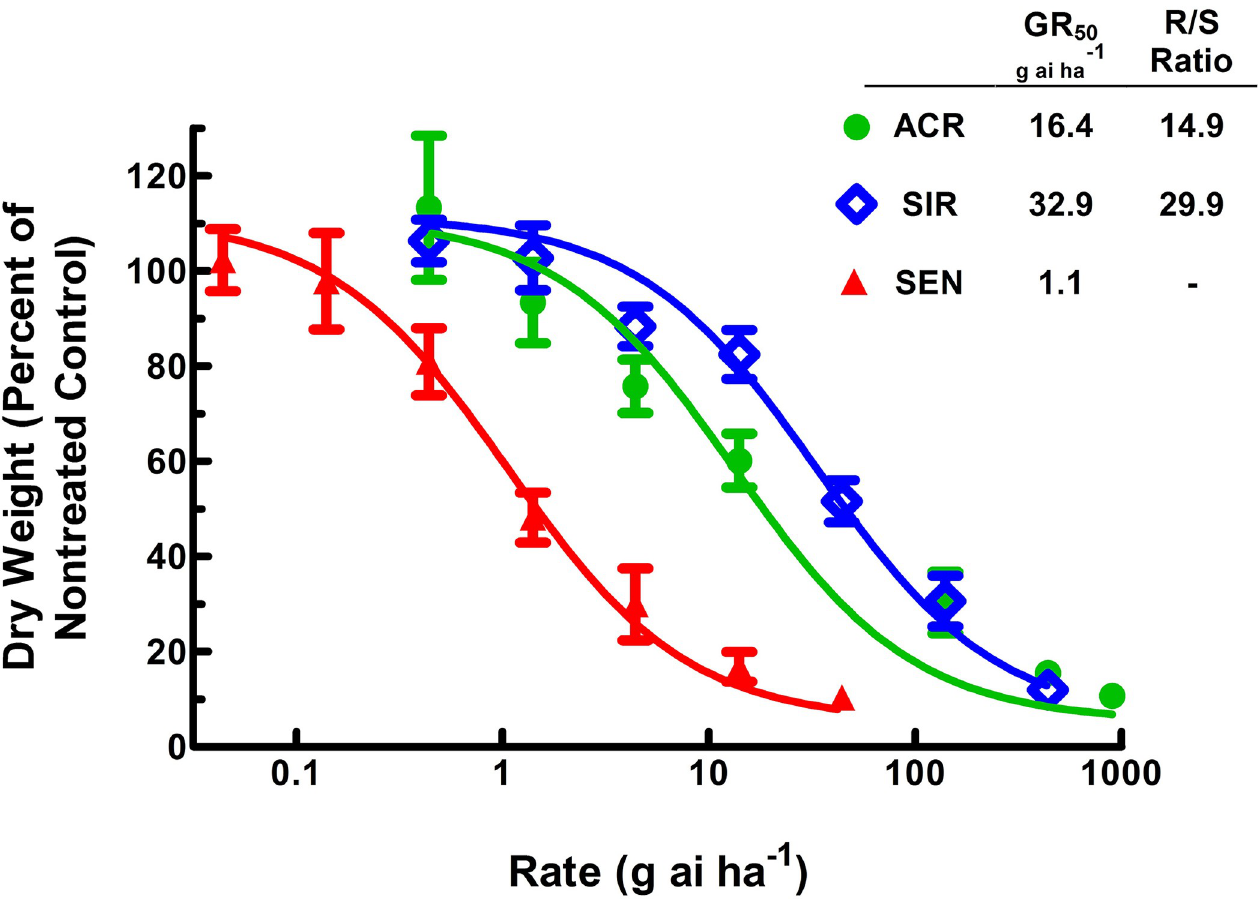
Fig 3. Quantitative dose-response analysis of carfentrazone-ethyl (CE) with the ACR, SIR, and SEN populations at 10 DAT. The fold-resistance ratio (R/S ratio) is the quotient of the GR 50 from the specified resistant population (ACR or SIR) and the GR 50 of SEN. The field-use rate for CE is 14 g ai ha -1 , and seedlings were 9–11 cm tall at time of treatment. Vertical bars represent the standard error of the mean. Dry weights are expressed as a percentage of the nontreated control.